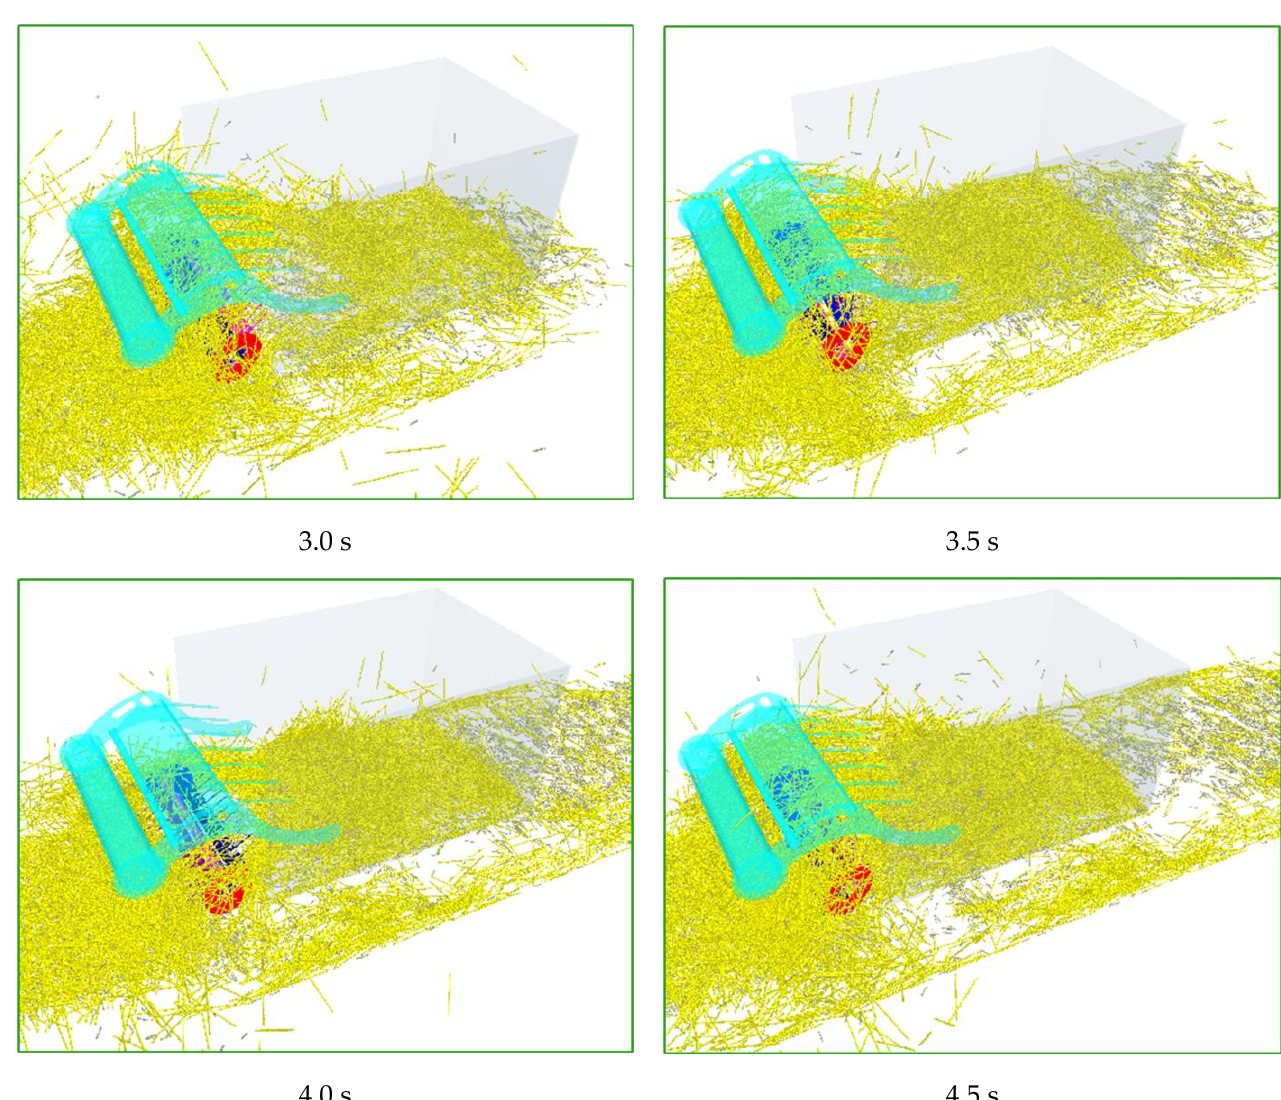
Figure 7. Simulation effect at different moments.